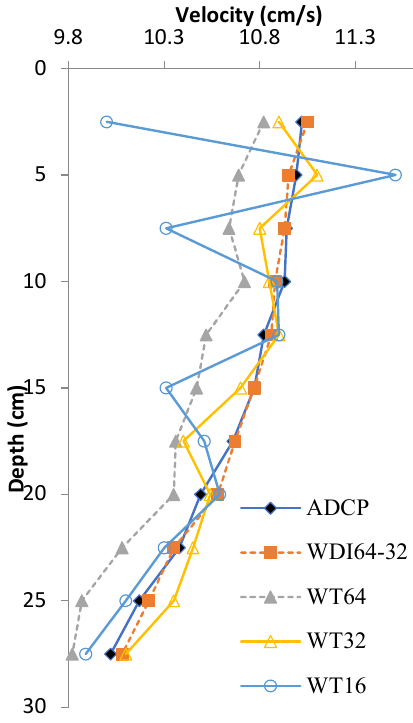
Figure 10. Profiles obtained by five different methods.